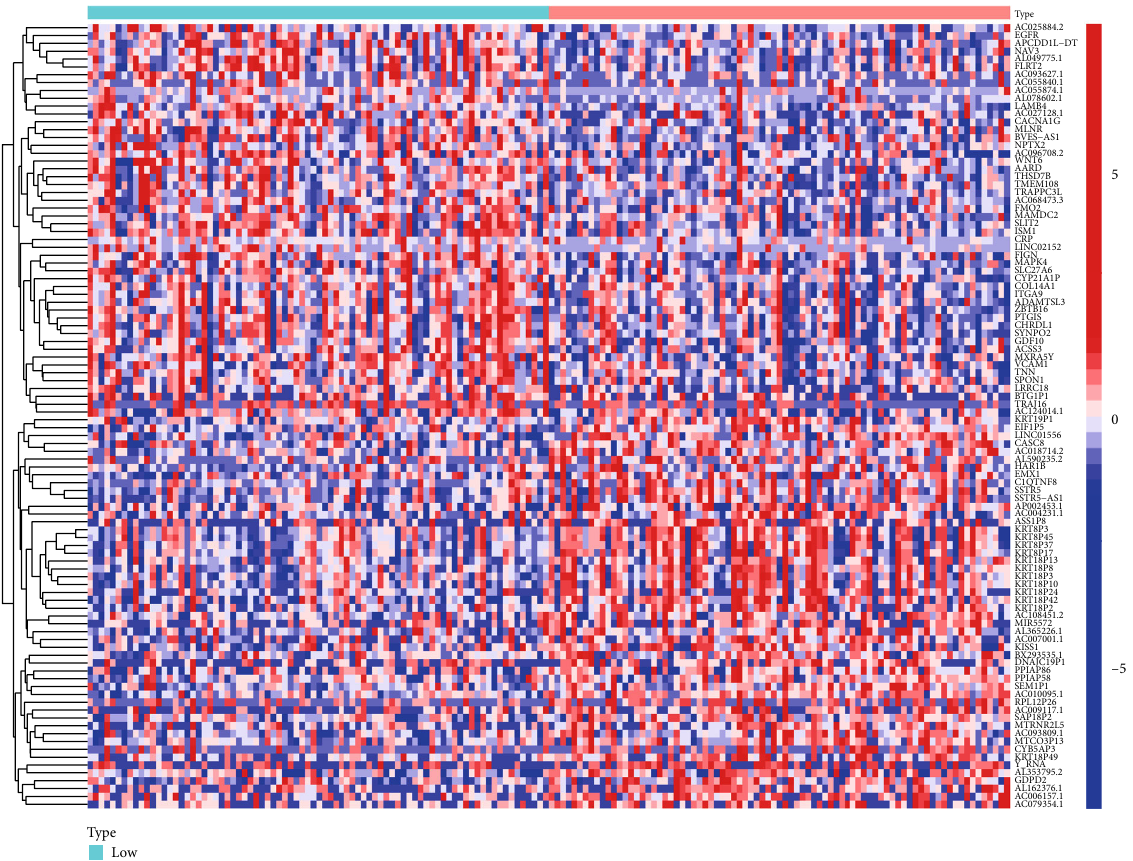
Figure 6: Heatmap of the DEGs between ESCA specimens with high COX7B expression and ESCA specimens with low COX7B